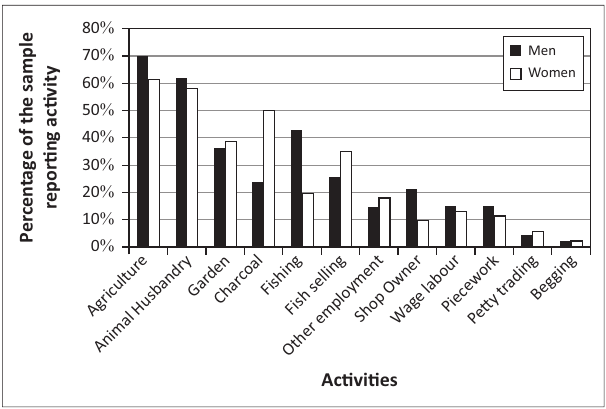
FIGURE 6: Livelihoods activities by gender in Kasaya.